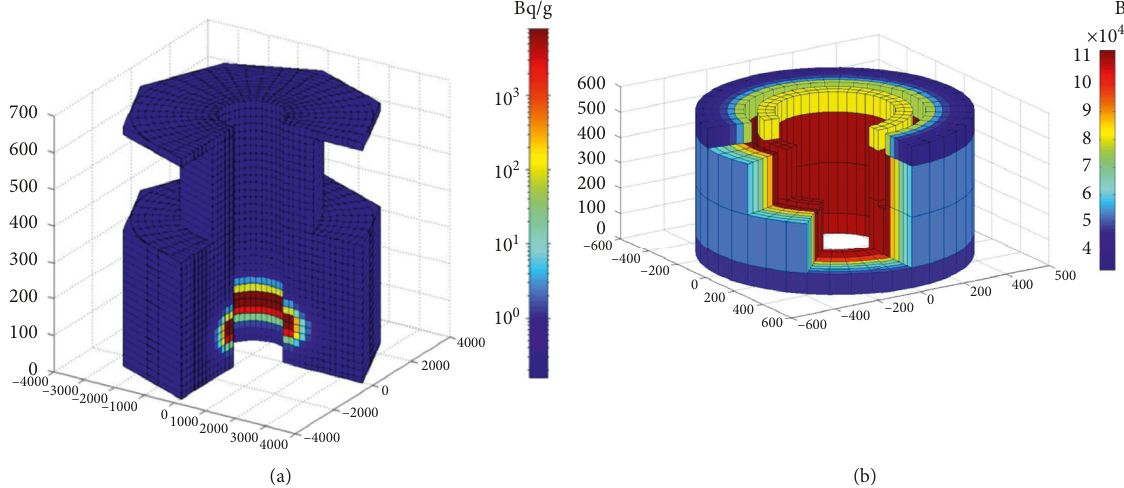
Figure 10: Distribution of the specific radiation activity in the reactor shielding (a) and graphite reflector (b) after reactor